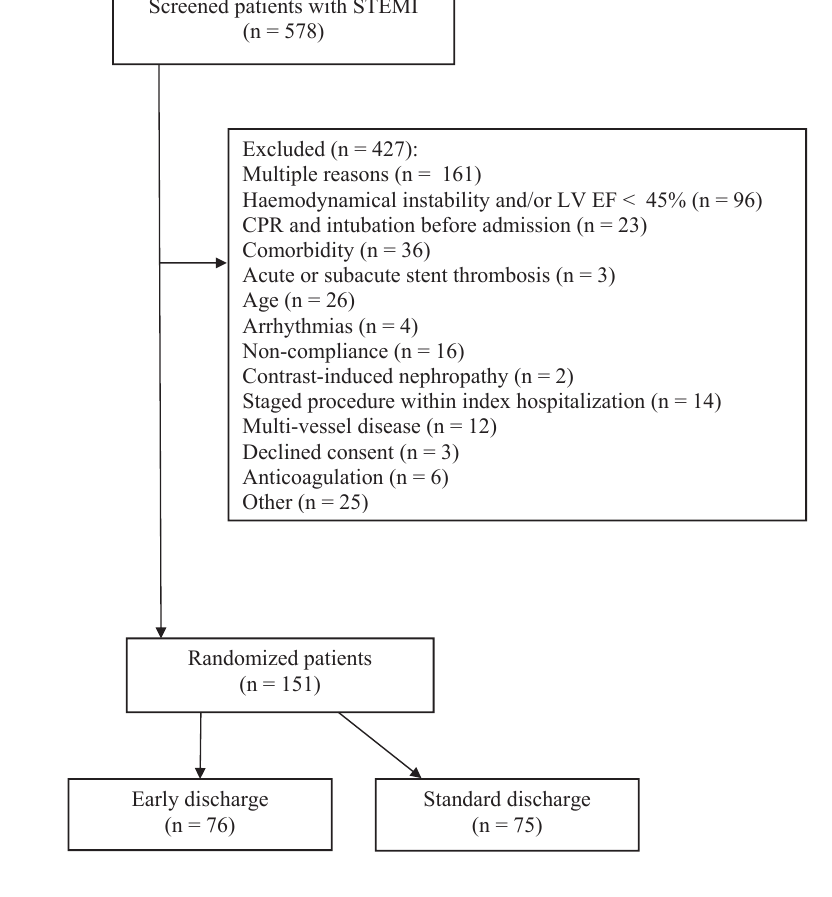
Fig. 2. Patient flow.